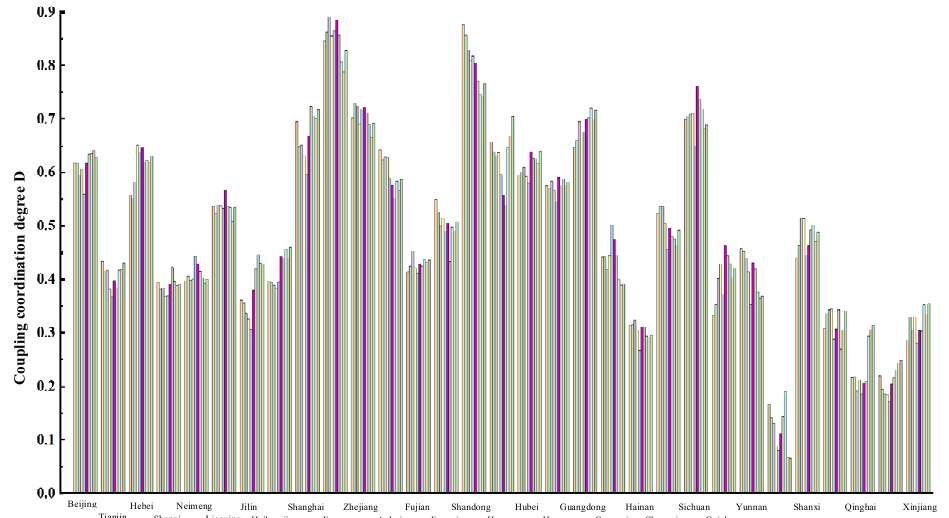
Figure 4. Coupling degree between supply and demand in every region from 2010 to 2019.